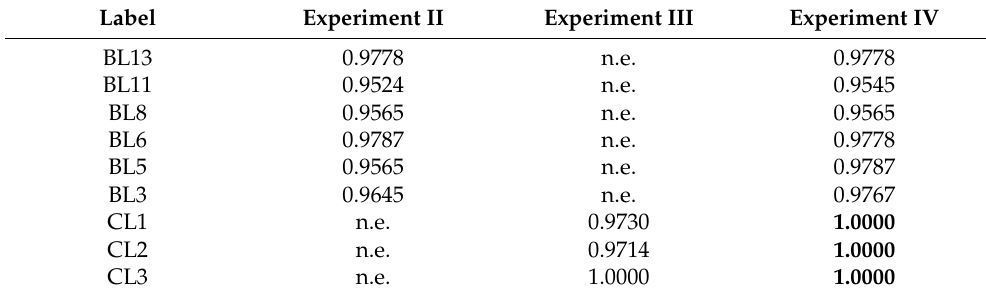
Table 9. Results of F1 scores for each sample obtained from ResNet-GBM in Experiments II, III, and IV.